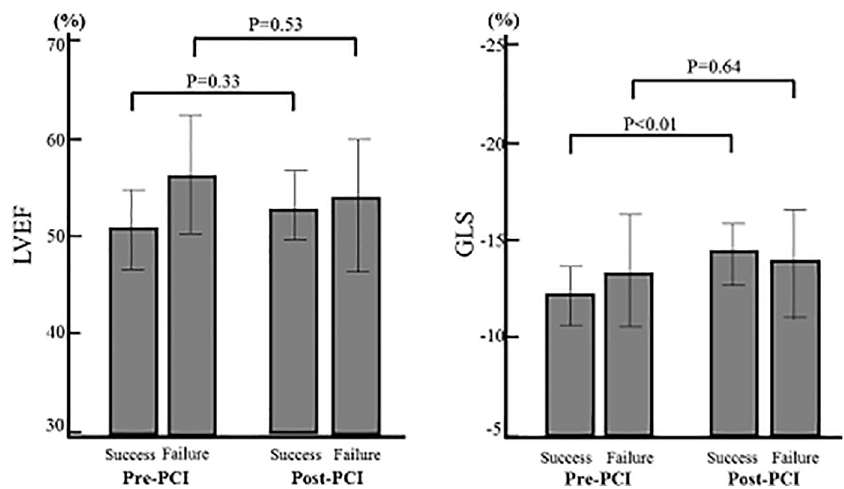
Fig 3. Change of LV function from baseline to 9 months after PCI. GLS in successful PCI group was significantly improved (P < 0.01), whereas in failed PCI group that did not change significantly. LVEF showed no significant improvement in both successful and failed PCI groups.